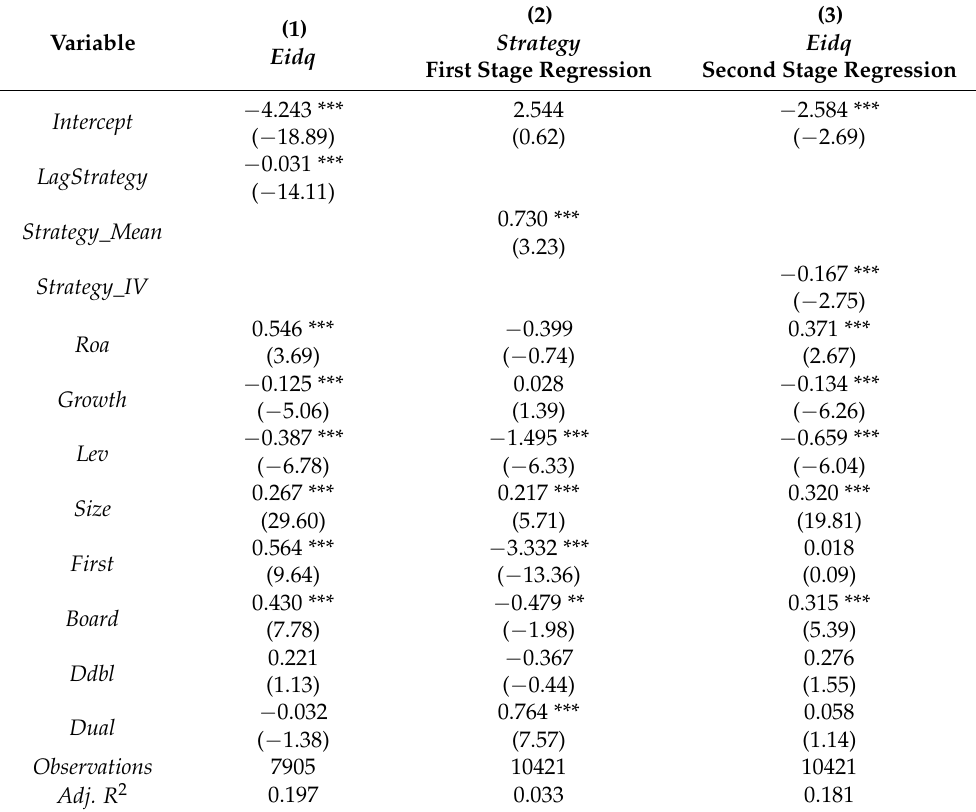
Table 7. Business strategy and environmental information disclosure quality: Endogeneity